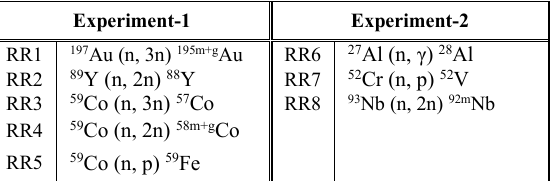
Table 1. Dosimetry reactions in the two experimental sets, where each reaction has been numbered (RRx) for